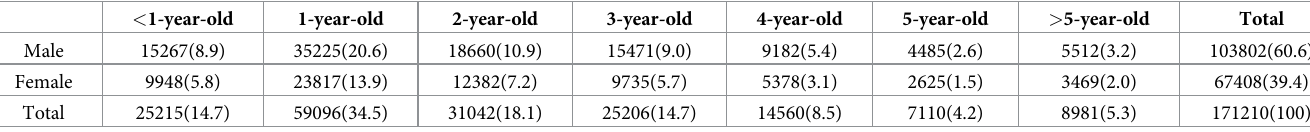
Table 1. Descriptive statistics of the basic characteristics of the HFMD cases [n